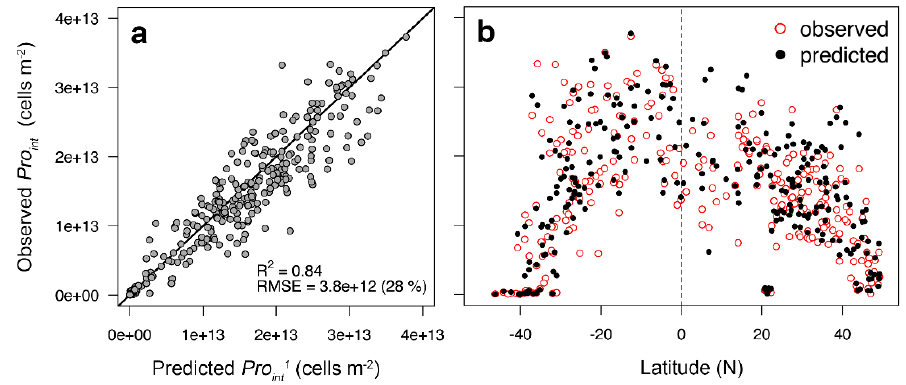
Figure 5. Vertical profiles of Prochlorococcus cell abundance over depth ( Pro total ( z )) across the Atlantic Ocean (locations displayed in Figure 1): ( a ) observed in situ on AMTs 12 – 24 ( Pro total ( z ) ′ ); ( b ) predicted using the partial model with observed inputs of Pro surf and Z DCM ( Pro total ( z ) 1 from Equations (1) to (2) and (6) to (7)); and ( c ) predicted using the full model with remote-sensing inputs ( Pro total ( z ) 3 from Equations (1) – (9).